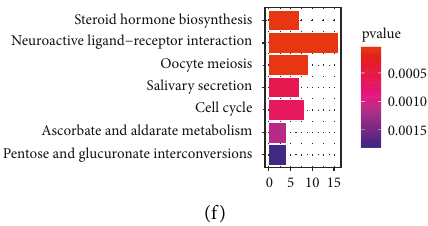
Figure 4: Generation of a bone metastasis-related ceRNA network. (a-c) Differentially expressed lncRNAs (a), miRNAs (b), and mRNAs (c) identified when comparing the LRBM and HRBM cohorts. The top 10 upregulated and downregulated genes are shown for each category, with horizontal lines corresponding to an adjusted P value of 0.05. (a, c) Vertical lines correspond to a log2 (fold change) at − 1 and 1. (b) Vertical lines correspond to a log2 (fold change) at − 0.58 and 0.58. (d) A ceRNA network was generated in which lncRNAs, miRNAs, and mRNAs were represented by hexagons, rhombuses, and ovals, respectively. (e) Enriched GO terms associated with mRNAs differentially expressed between the LRBM and HRBM cohorts, with the top 10 terms in each of three categories being shown. BP: biological processes. CC: cell component. MF: molecular function. (f) KEGG enrichment analyses for mRNAs differentially expressed in the HRBM and LRBM cohorts. The brown module was composed of five genes that were upregulated in HRBM patient samples, among which COL10A1 was the hub gene (Figure 5(h)). These five genes were enriched for GO terms including extracellular matrix structural constituent, extracellular matrix structural constituent conferring tensile strength, heparin binding, glycosaminoglycan binding, and sulfur compound binding (Figure 5(i)), as well as the protein digestion and absorption of KEGG pathway (Figure 5(j)). In the brown module PPI network, COL11A1 and COL10A1 were predicted to interact (Figure